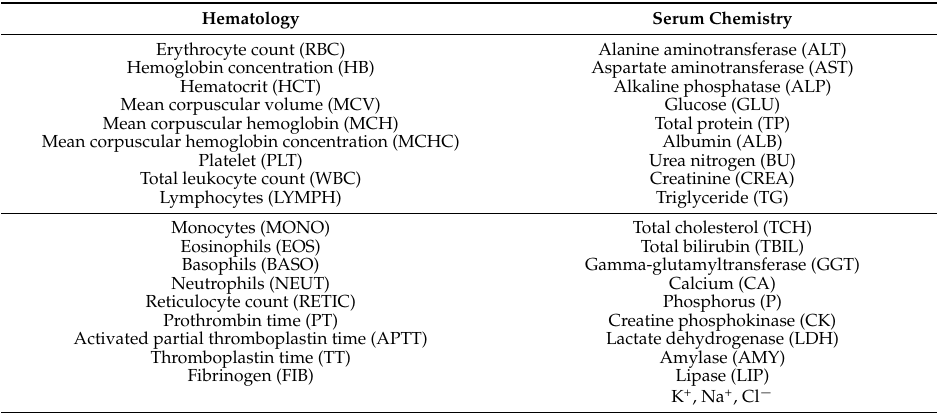
Table 2. Parameters evaluated in hematology and serum